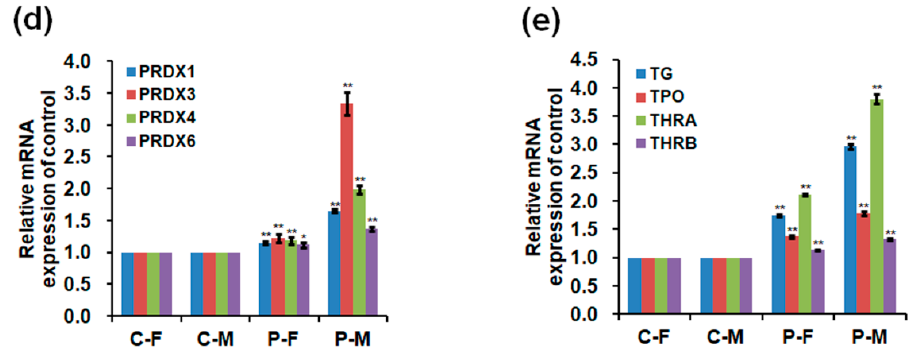
Figure 6. Relative mRNA levels of ( a ) ATP5 synthase; ( b ) GH , growth hormone receptor ( GHR ), IGF1 , insulin-like growth factor 1 receptor ( IGF1R ), IGFBP2 , and POU class 1 homeobox 1 ( POU1F1 ); ( c ) adenosine monophosphate-activated protein kinase ( AMPK ) α 2 , AMPK β 2 , AMPK γ 3 , and mammalian target of rapamycin ( mTOR ), and ( d ) peroxiredoxin ( PRDX ) 1 , PRDX3 , PRDX4 , and PRDX6 in the skeletal muscles of 90-day-old chickens; Relative mRNA levels of thyroglobulin ( TG ), thyroid peroxidase ( TPO ), thyroid hormone receptor alpha ( THRA ), and thyroid hormone receptor beta ( THRB ) ( e ) in the thyroid glands of 90-day-old chickens. Data are presented as mean ± SD ( n = 10) of three replicates; n represents an individual chicken. *, p < 0.05 versus control; **, p < 0.01 versus control in females and males, respectively, according to the one-way ANOVA with an LSD test.